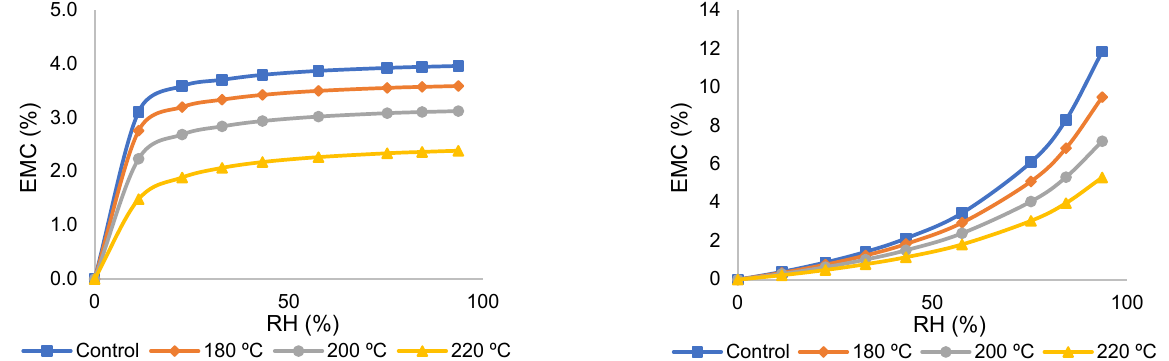
Figure 2. Monomolecular ( left ) and polymolecular ( right ) adsorption isotherms.